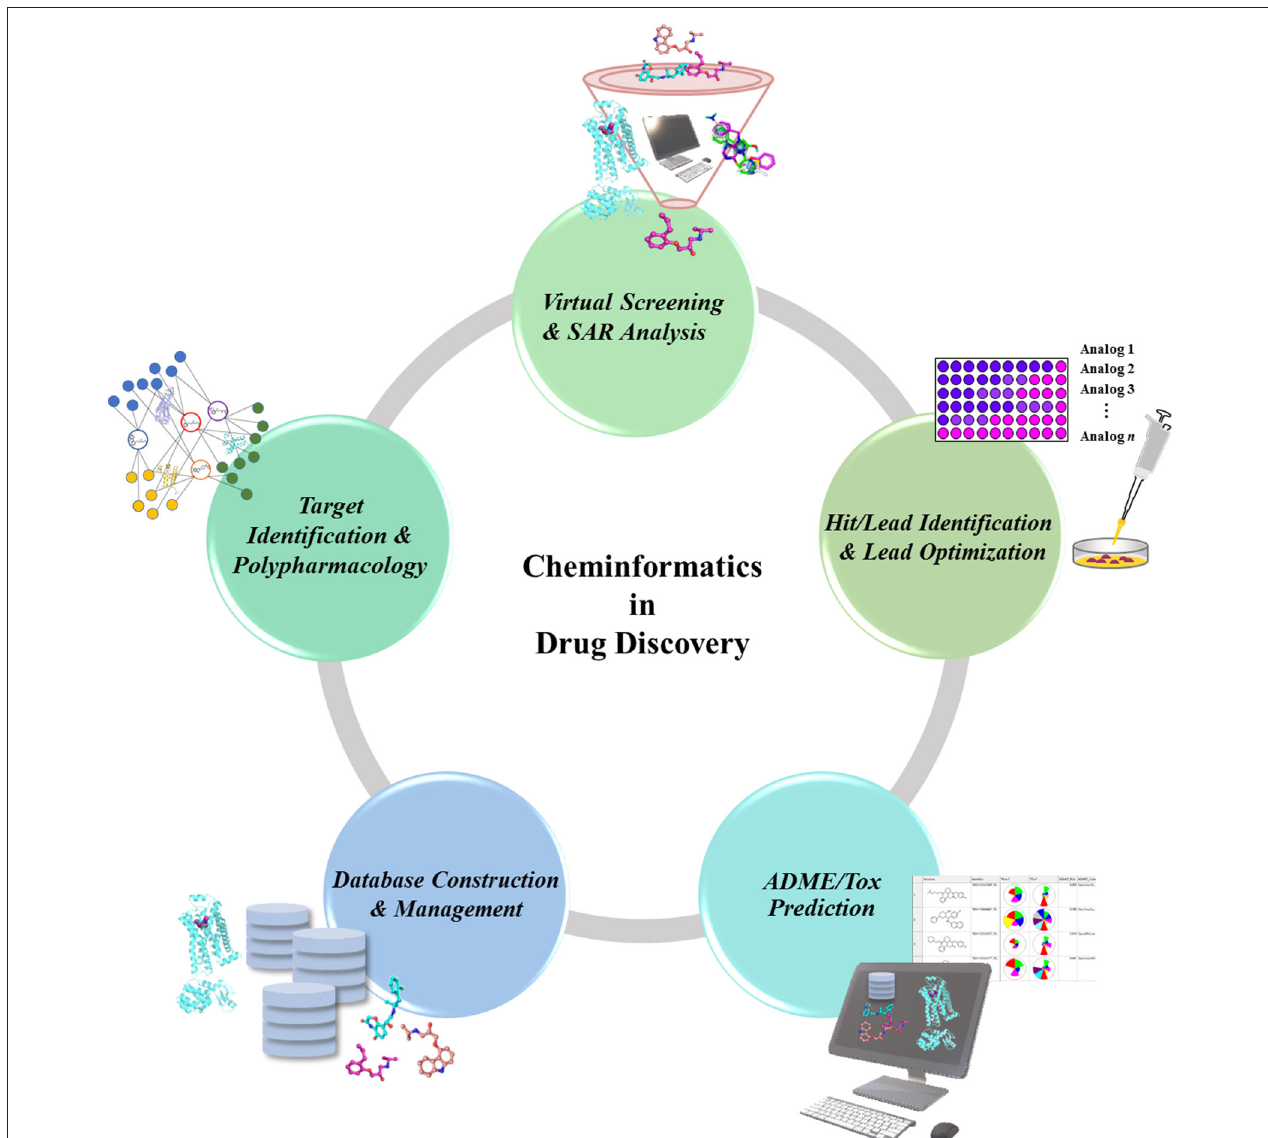
FIGURE 1 | Role of Cheminformatics in the drug discovery process. Cheminformatics is involved in almost every step of the drug discovery pipeline due to the employment and analysis of available data to translate into valuable knowledge, which can in turn be used as a data for further